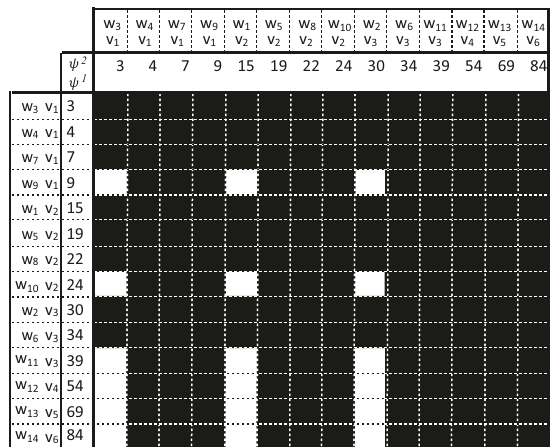
Figure 13: Adjacency matrix 𝐴 𝜌 (𝜙,𝜓) composed of sequence events (dark filled) for the chronic diabetes